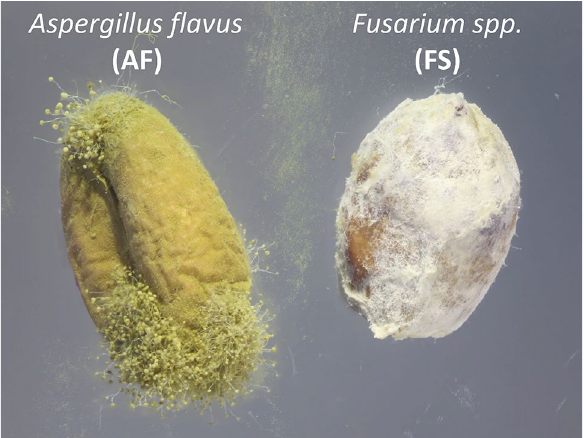
Figure 8. Habitus images of morphotype 1 (left, A. flavus -inoculated grain) and morphotype 2 (right, F. verticillioides -inoculated grain) at ×10 magnification (SMZ-18, Nikon Inc., Tokyo, Japan) on grain after inoculation